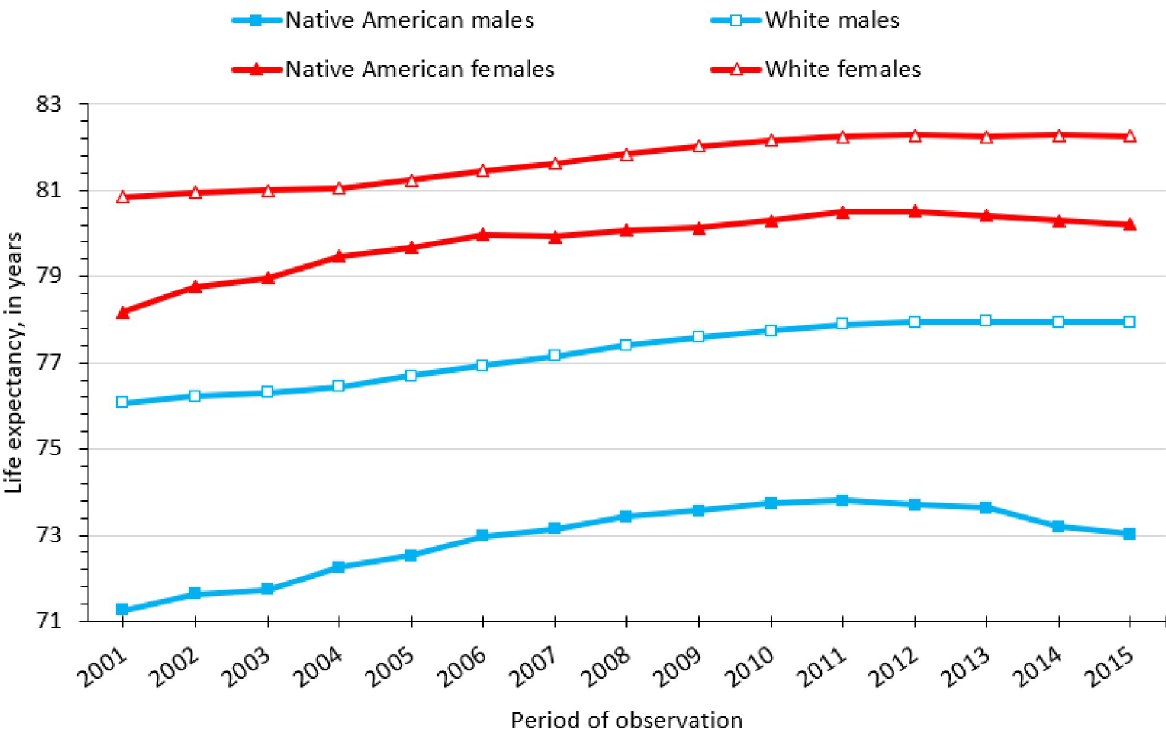
Fig 1. Life expectancy among Native American and White in the Four Corners States, 2001–2015. Each period represents a 5-year aggregation of data. https://doi.org/10.1371/journal.pone.0256307.g001 Table 1 presents contributions of the 10 leading U.S. causes of death to Native American- White life expectancy gaps in 2001, 2008, and 2015. For each cause of death in each time period, contributions were quantified as the years gained or lost among Native Americans